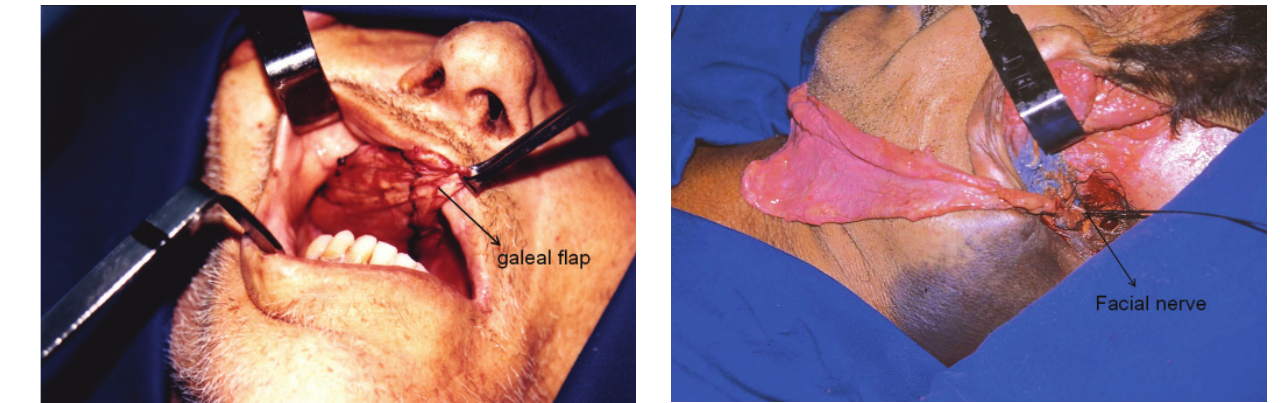
Figure 4 - Galeal flap transposed to the neck under the facial